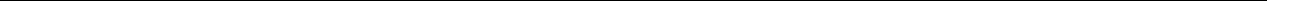
Fig. 4 Interaction of APE1 with the DROSHA complex is stimulated by oxidative stress. a Nucleoplasmic interaction between APE1 and the DROSHA complex after oxidative stress. HeLa cells were placed on a glass coverslip and treated with 1 mM H 2 O 2 for 15, 30, and 60 min. PLA reaction was carried out using anti-APE1 and anti-DROSHA antibodies. APE1 expression was detected by using an anti-APE1 antibody and was used as a reference for the nuclei. Data reported in the histogram account for the average number of PLA signals of at least 30 randomly selected cells per condition. ** P < 0.001, Student ’ s t -test. b miR-221 and miR-222 expression levels evaluated by qRT-PCR analysis of HeLa cells treated with 1 mM H 2 O 2 for 15 min and released for 1, 3 or 6 h after treatment. Histograms show the detected levels of pri-miR-221 and pri-miR-221 normalized to GAPDH levels (left) and the ratio between mature miRNAs relative to their GAPDH-normalized precursors ( right ). Asterisks represent a signi fi cant difference with respect to control (NT). NT non-treated. * P < 0.05, ** P < 0.001, Student ’ s t -test. c Total RNA, isolated from HeLa cell clones, was reacted with aldehyde-reactive probe speci fi cally on oxidative abasic sites, followed by precipitation with magnetic beads. Precipitated oxidized RNA and total RNA were subjected to qRT-PCR individually using TaqMan probe for pri-miR-221 or pri-miR-222. Oxidation levels of miRNAs were determined based on difference in Ct value between oxidized and total RNA. Data are represented as mean ± SD after three replication tests. * P < 0.05, Student ’ s t